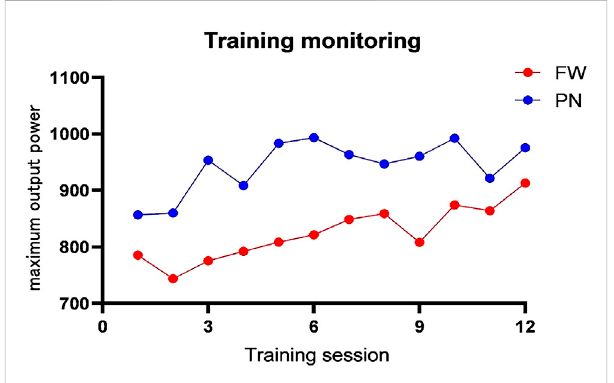
FIGURE 2 Training monitoring change curve (maximum output